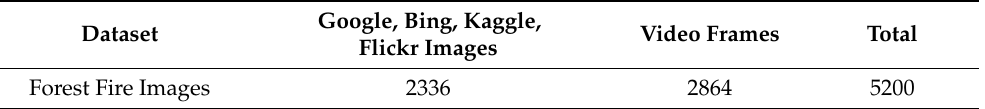
Table 1. The custom dataset of the forest fires.